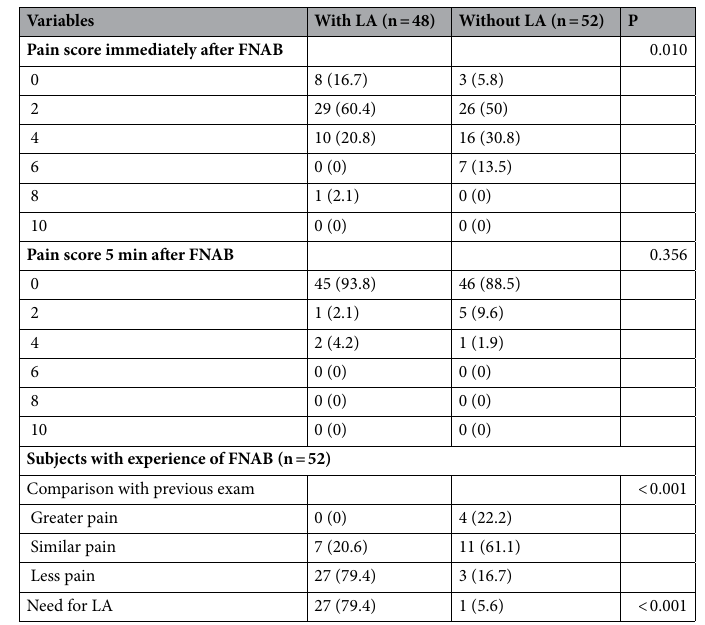
Table 2. Pain characteristics in the patients undergoing FNAB with and without LA. Data were presented as count (percentage). FNAB, fine-needle aspiration biopsy; LA, local anesthesia.